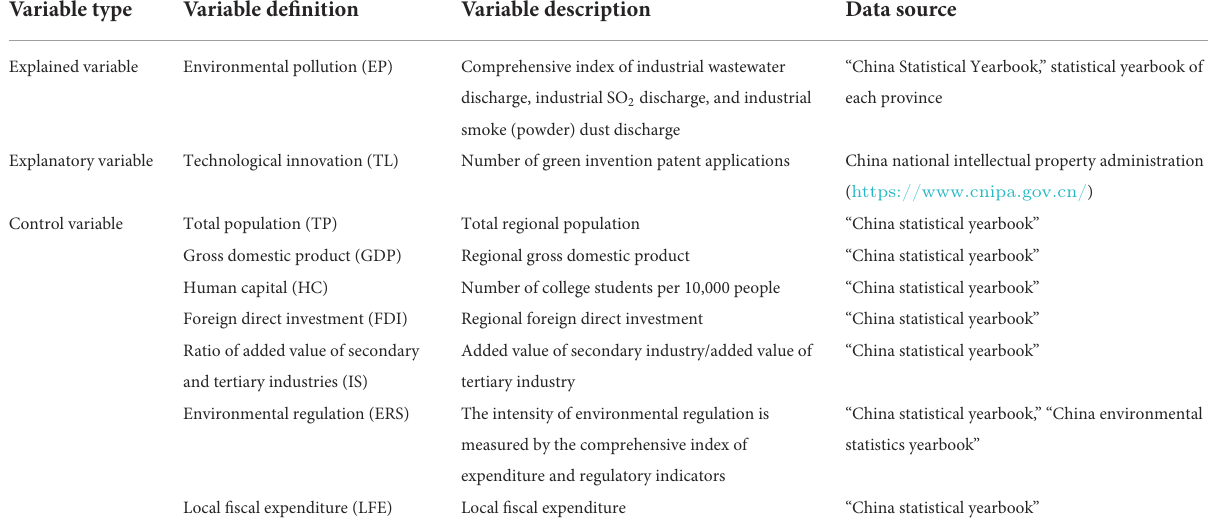
TABLE 1 Variable